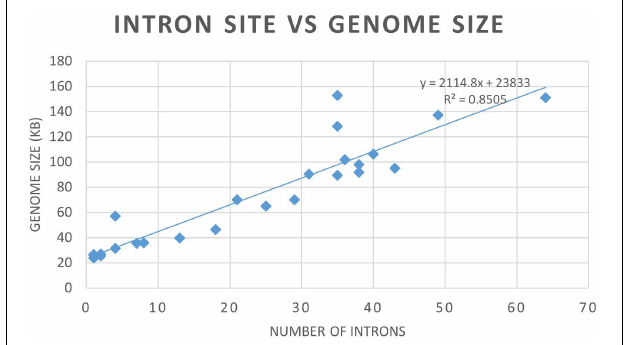
FIGURE 6 | Graph depicting the relationship between mitogenome sizes and intron numbers per mitogenome for the examined members of the